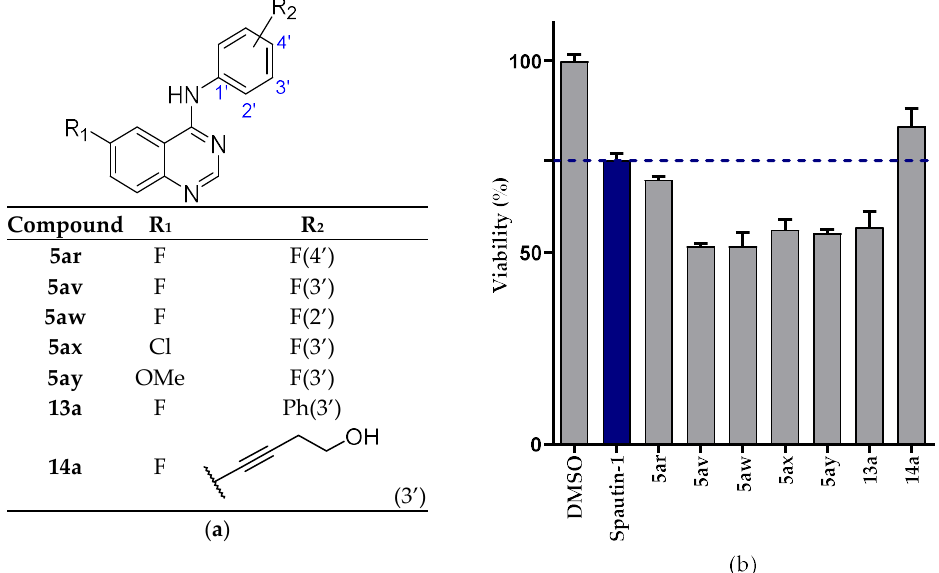
Figure 8. ( a ) Spautin-1 analogues with a reduced chain length; ( b ) viability assay (5 µ M) with Spautin-1 as reference. Nonetheless, the most promising compounds have an extended chain between the secondary amine and the phenyl group. Highly comparable results were obtained for all analogues, except for analogue 5bd , which was significantly less potent at a test concentra- tion of 5 µ M (Figure